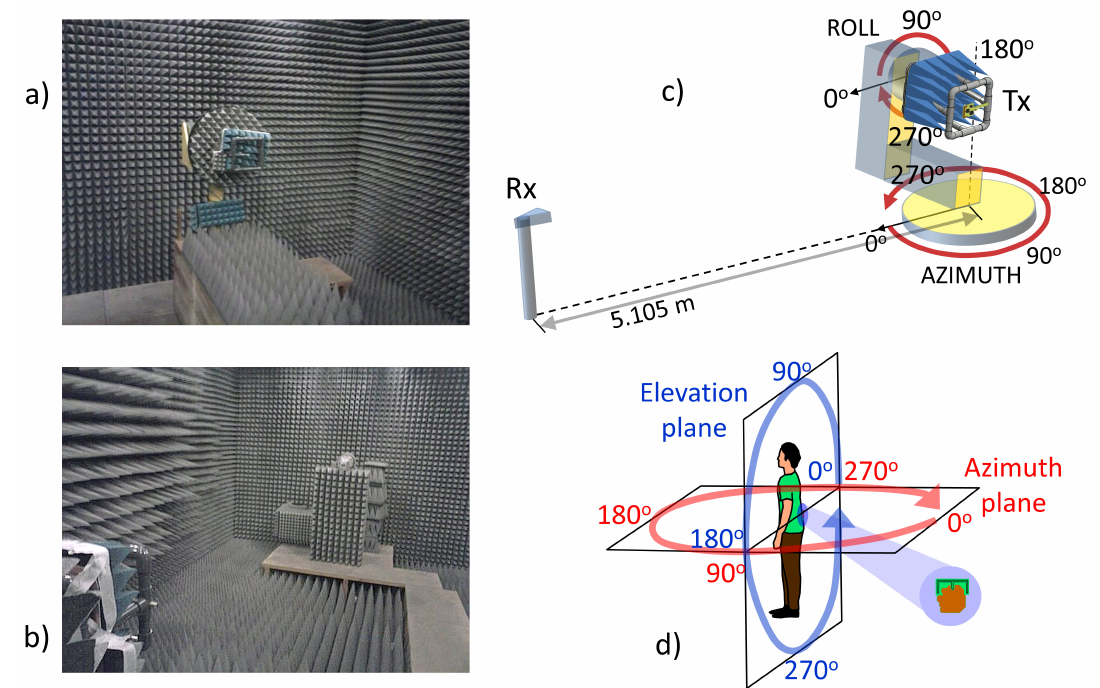
Figure 3. ( a ) Interior of the anechoic chamber with the Tx in the background; ( b ) Interior of the anechoic chamber with the Rx in the background; ( c ) Scheme of the arrangement of the Tx and Rx devices inside the anechoic chamber and definition of the measurement planes; ( d ) Distribution of angles for